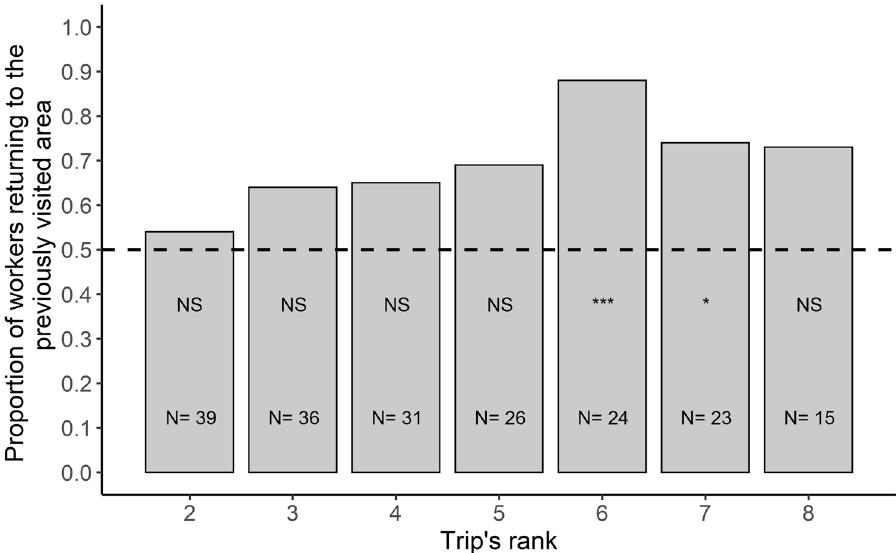
Figure 4. Individual experiment: proportion of foragers returning to the previously visited area as a function of the rank of the foraging trip. N values represent the number of ants for each trip’s rank. A binomial test was carried out for each trip’s rank. Binomial tests; NS: non-significant, *:P ≤ 0.05, ***:P ≤ 0.001.